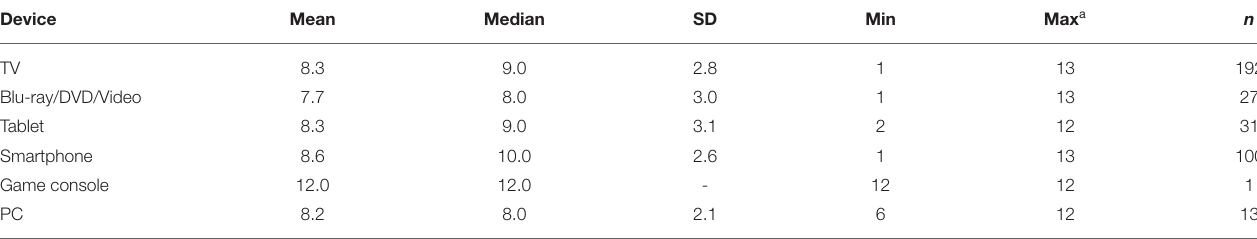
TABLE 2 | Age in months at first exposure to different digital media.